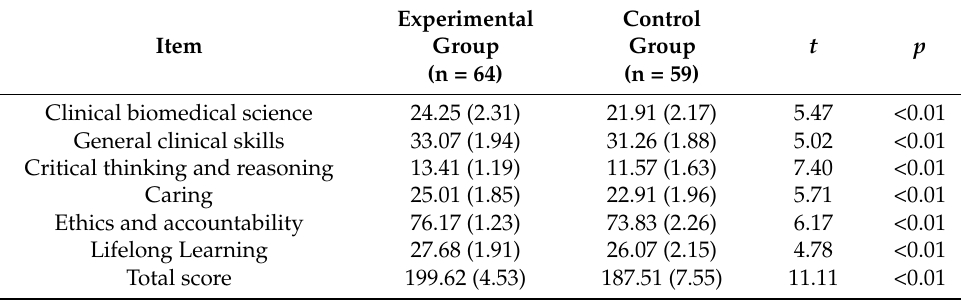
Table 1. Comparison of the CINS scale scores between two groups (point,